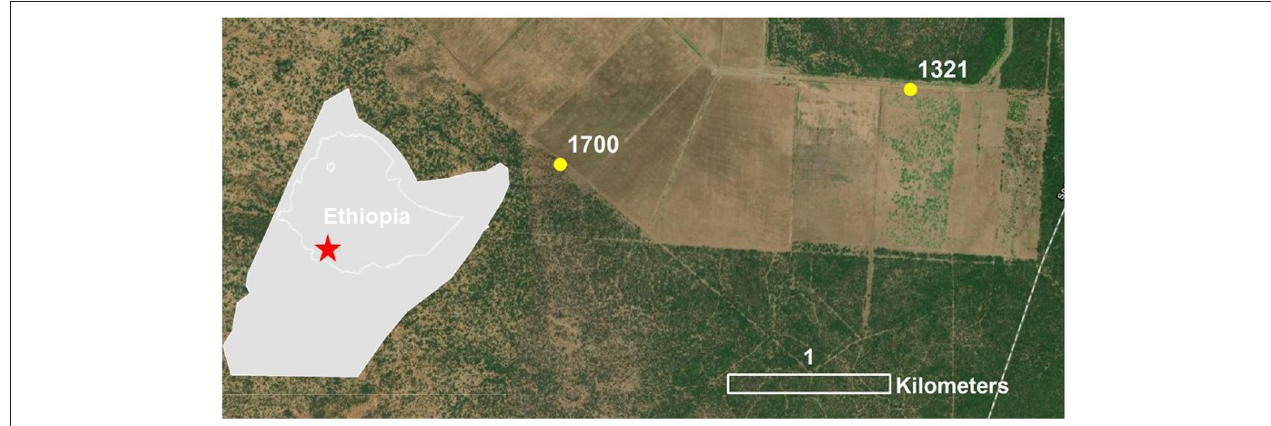
FIGURE 3 | Band observation sites in Ethiopia where NDVI derived from HLS was compared with NDVI derived from